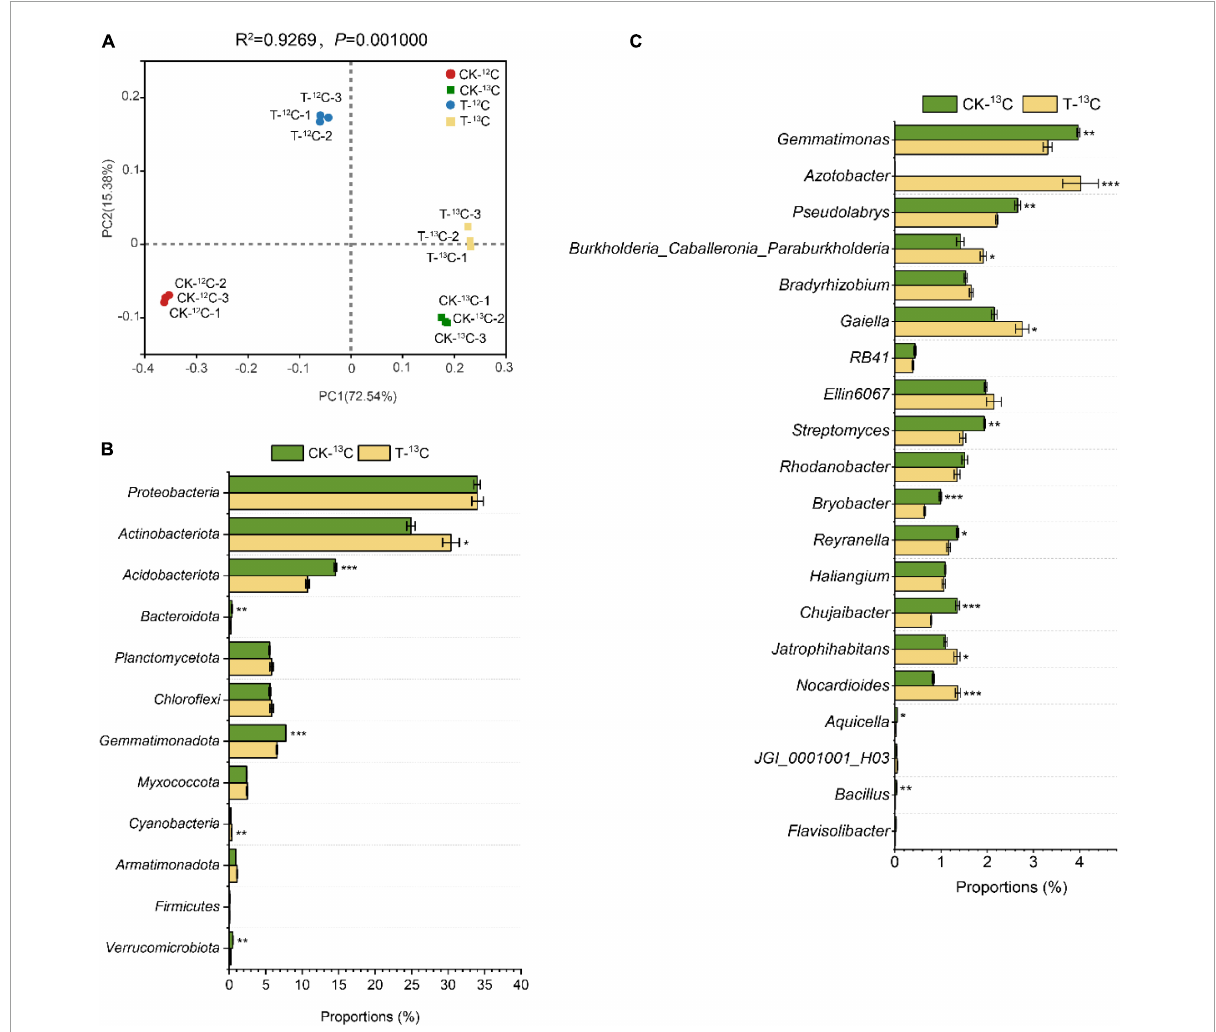
FIGURE4 (A) Principal co-ordinates analysis based on Bray–Curtis distances of bacterial communities in soil samples of 12 C and 13 C-labeled DNA under CK and 4-HBA treatments (T) (ADONIS test). (B) Relative abundance of different bacterial taxa at the phyla level and major variations in soil samples between CK- 13 C and T- 13 C. (C) Relative abundance of different bacterial taxa at the genus level and major variations in soil samples between CK- 13 C and T- 13 C. Bars represent means ± standard errors ( n = 3). The asterisk indicates significant differences between CK- 13 C and T- 13 C (Student’s t -test, * p < 0.05; ** p < 0.01; *** p <